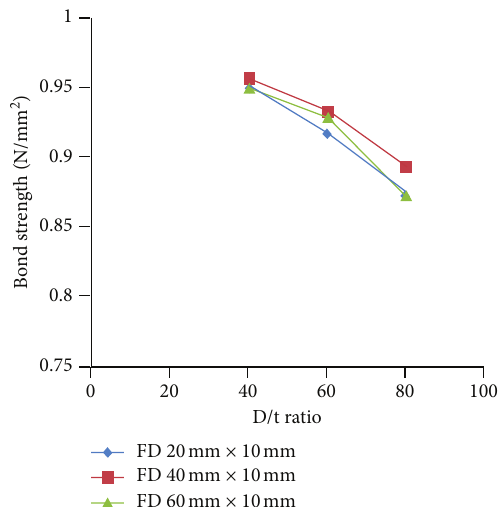
Figure 12: Variation in bond strength with D / t